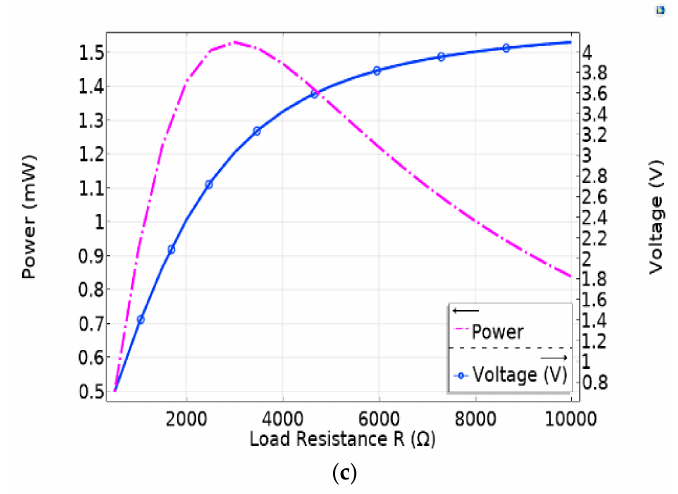
Figure 5. Load response curves of the PVEH (whose L = 100 mm, b 0 = 35 mm, and T = 0.7) segmented at strain nodes of the third vibration mode at a mechanical excitation of 0.5 g for the ( a ) first, ( b ) second and ( c ) third resonant frequency. Optimal loads are ( a ) 1.3 k Ω , ( b ) 1.1 k Ω , and ( c ) 2.7 k Ω .